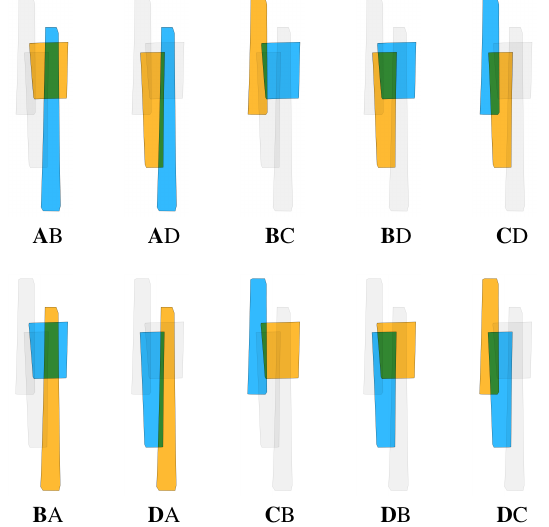
Figure 5: Pairwise sub-blocks for the block shown in Figure 4; blue: primary strip; orange: secondary strip Using multi-strip sub-blocks, as shown in Figure 6, each strip is selected as primary strip only once. For the same example, this results in four sub-blocks. The number of secondary strips (or- ange) varies, depending on the number of overlapping strips. In this way tie points observed in more than ten images are possible.